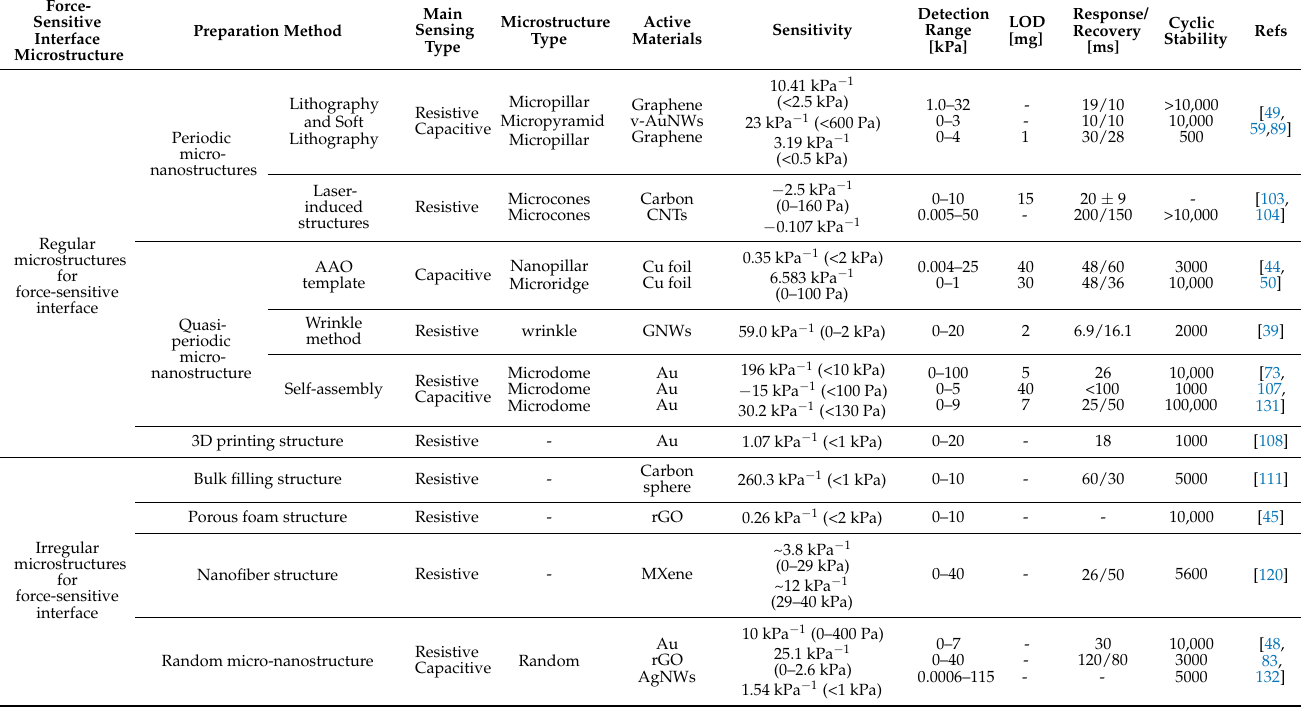
Table 1. Summary of some flexible pressure sensors with different force-sensitive interface microstruc- tures and their performance